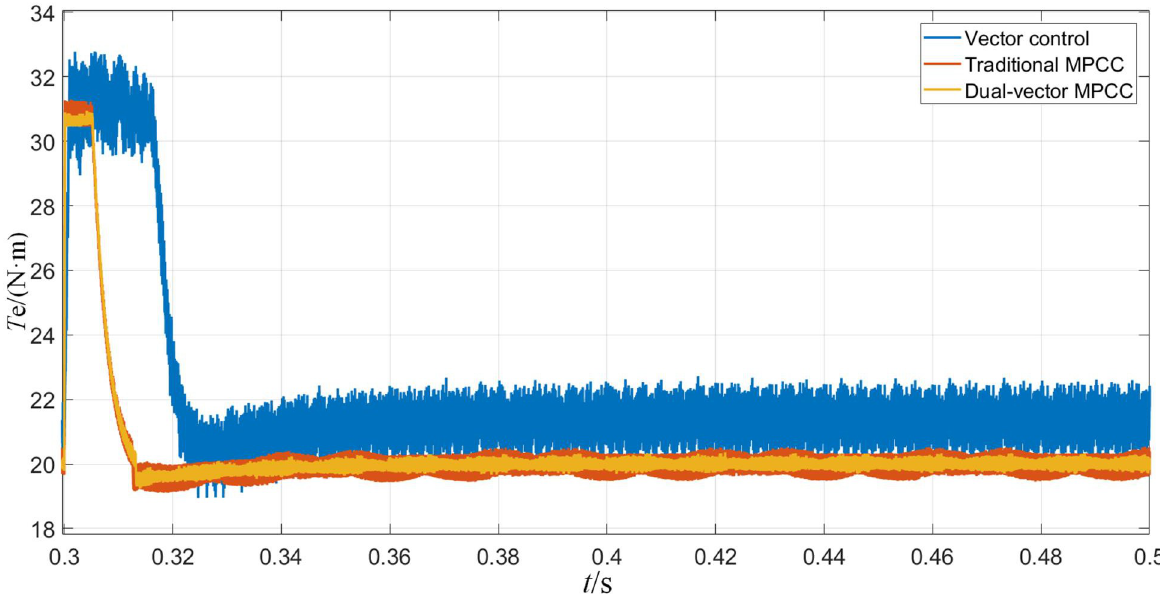
Fig 14. Torque waveform when the given speed